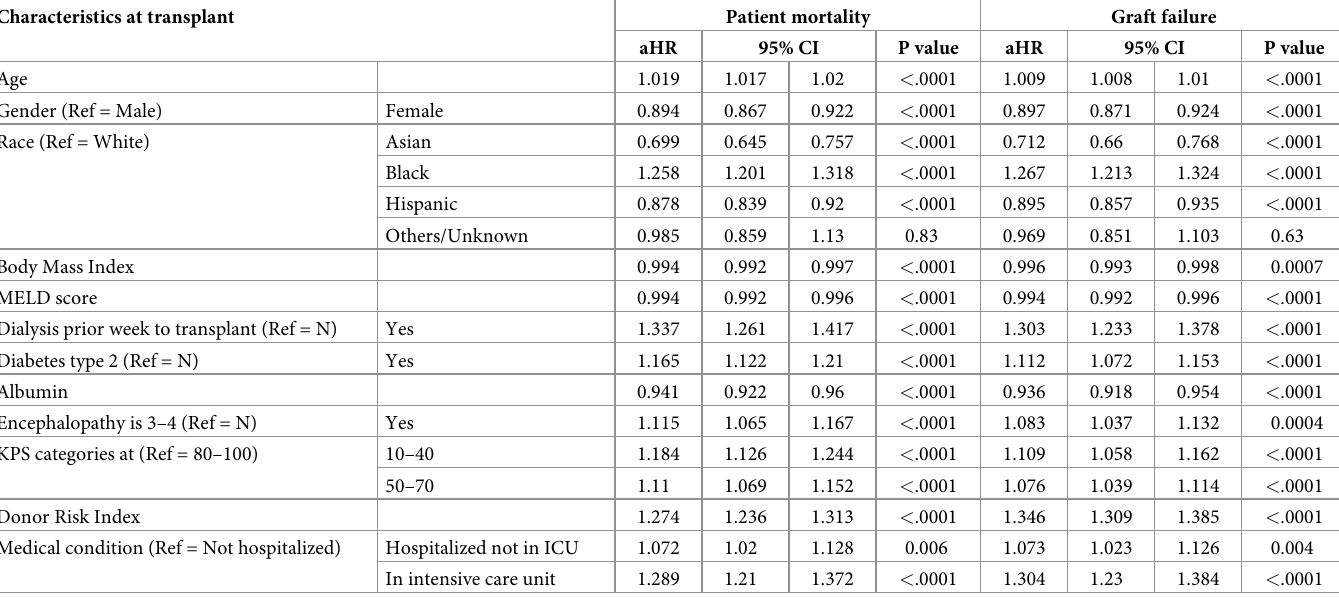
Table 4. Adjusted Hazard Ratios (aHR) on patient mortality and graft failure �